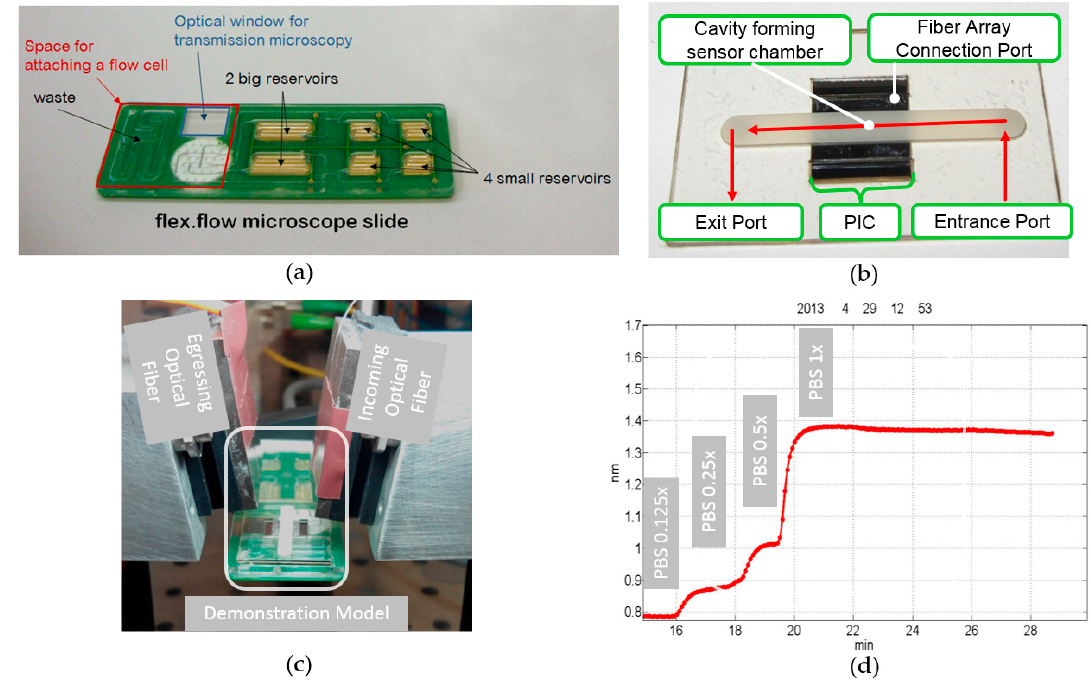
Figure 2. Demonstration model: ( a ) a standard flex.flow cartridge used for the study of the interfacing method between a microfluidic cartridge and the photonic sensor; ( b ) flow cell developed to form a sensor chamber on top of the optical ring resonators; ( c ) picture of the experimental setup with optical fibers aligned to the demonstration model; and ( d ) plot of the resonance frequency shift of the observed optical ring resonator, while different concentrations of phosphate buffered saline (PBS) are pumped through the sensor chamber.